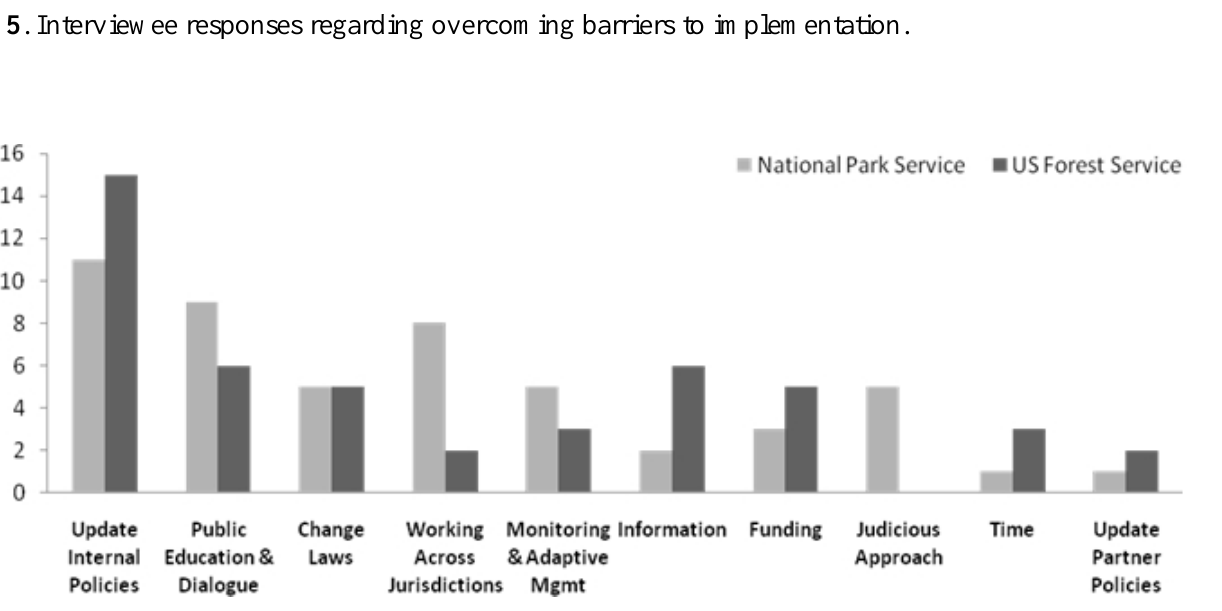
Fig. 5 . Interviewee responses regarding overcoming barriers to